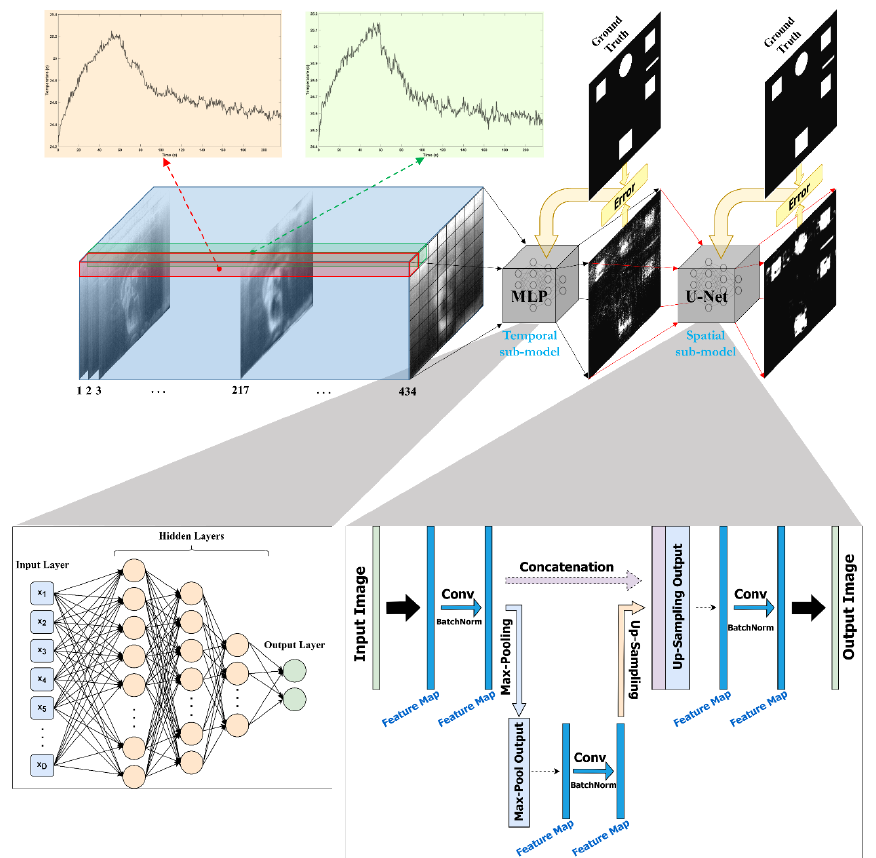
Figure 2. The complete flowchart of the current work includes: ( a ) object preparation for inspection, ( b ) configuration of the experimental set-up, ( c ) data preparation, ( d ) post-processing algorithm, ( e ) image reconstruction, and ( f ) output.